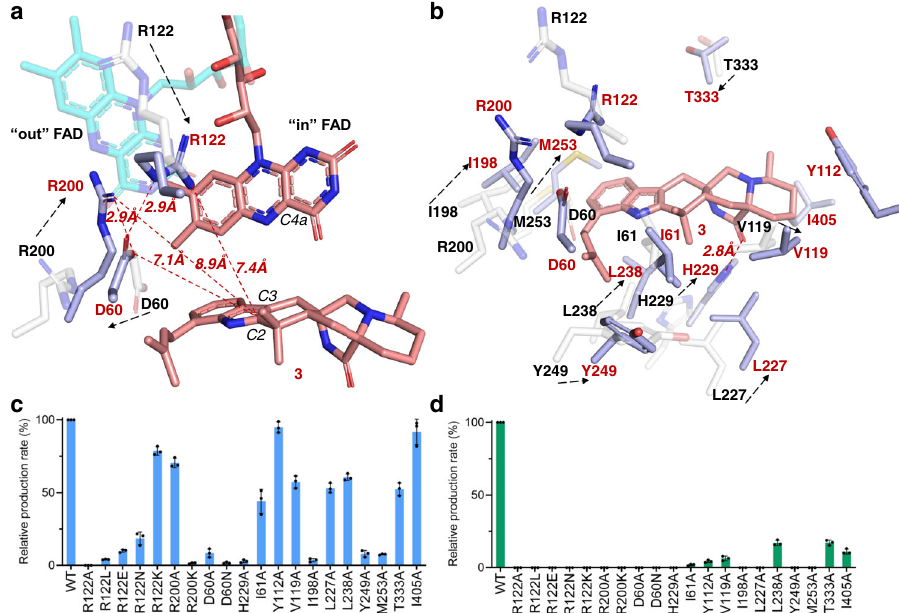
Fig. 5 Active site and substrate-binding site views of CtdE – FAD-3 complex and its substrate-free structure. a Overlay of the active site view of CtdE – FAD (residue carbons colored in white, FAD carbons colored in cyan) and CtdE – FAD- 3 (residue carbons colored in light blue and FAD carbons colored in red) complexes. b Overlay of substrate-binding site view of CtdE – FAD (residues carbons colored in white) and CtdE – FAD- 3 (residues carbons colored in light blue and carbons of compound 3 colored in red) complexes. c Analysis of the relative production rate of 3 with CtdE mutants. d Analysis of the relative production rate of 2 with CtdE mutants. Data represent the average of triplicate independent experiments (center values, mean; error bars, s.d.; n =